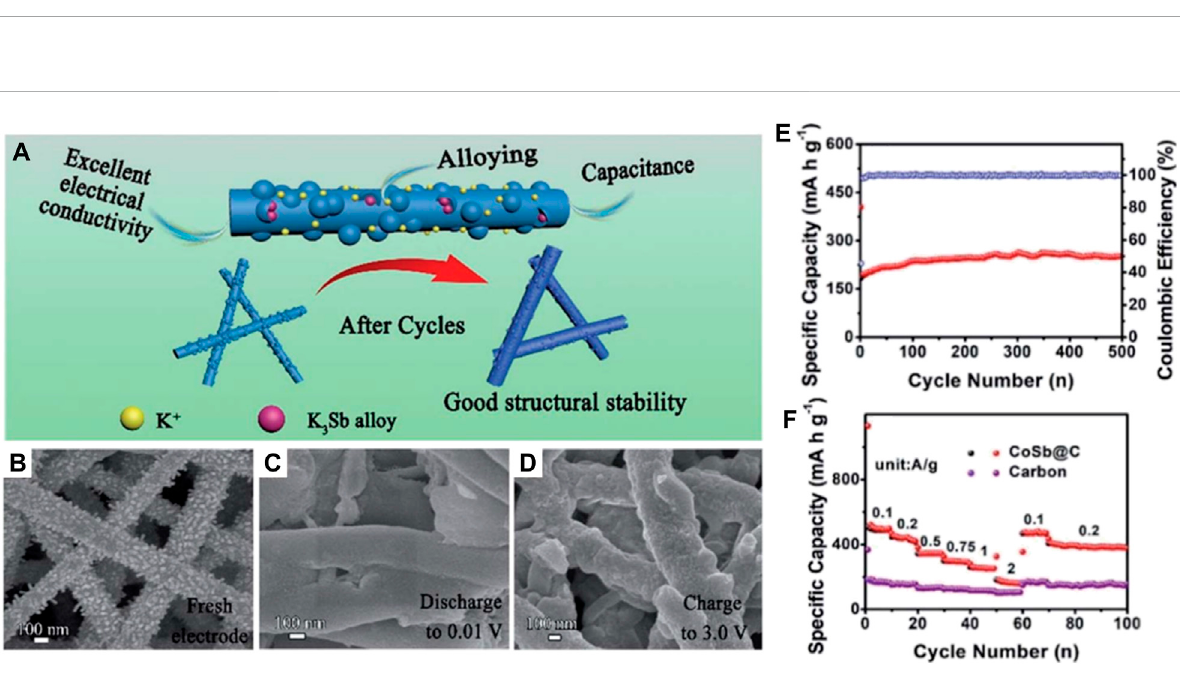
FIGURE 4 (A) Preparation diagram of the u-Sb@CNF free-standing electrode. (B) Rate properties of u-Sb@CNFs and Sb@s-CNFs. Reproduced with permission (Ge et al., 2019). Copyright 2019 WILEY-VCH. (C) SEM and (D) HRTEM images of Sb-G-C. (E) Schematic of the mixed K + storage mechanism of Sb-G-C nano fi bers. Reproduced with permission. (Huang et al., 2021). Copyright 2021 ESC.